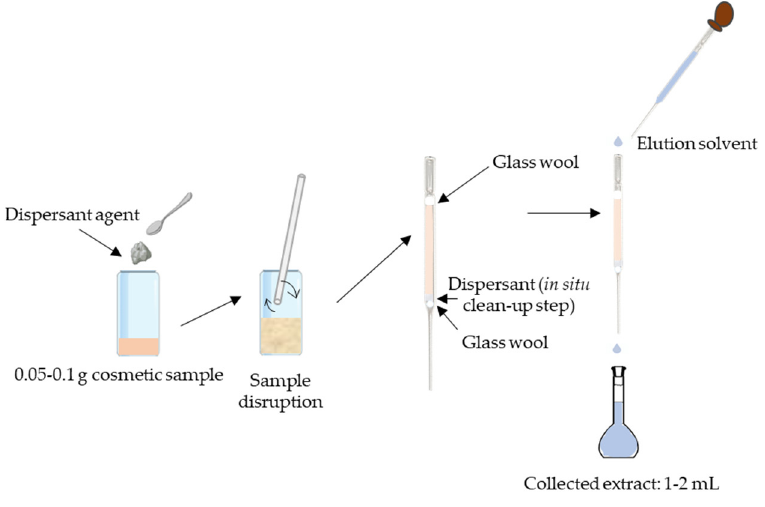
Figure 2. General μ -MSPD procedure employing a glass Pasteur pipette substituting classical car- Figure 2. General µ -MSPD procedure employing a glass Pasteur pipette substituting tridges. classical